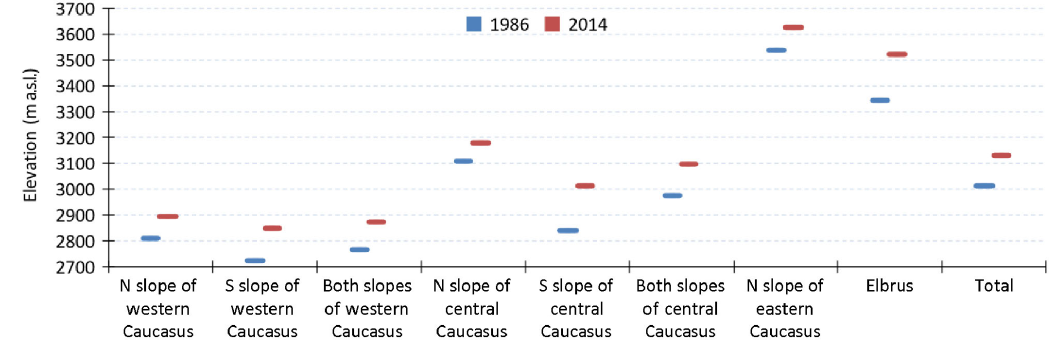
Figure 7. Mean upper limit (ma.s.l.) of the supra-glacial debris cover for 1986 and 2014 by different regions (glaciers are non-existent on southern slopes of the eastern Greater Caucasus).